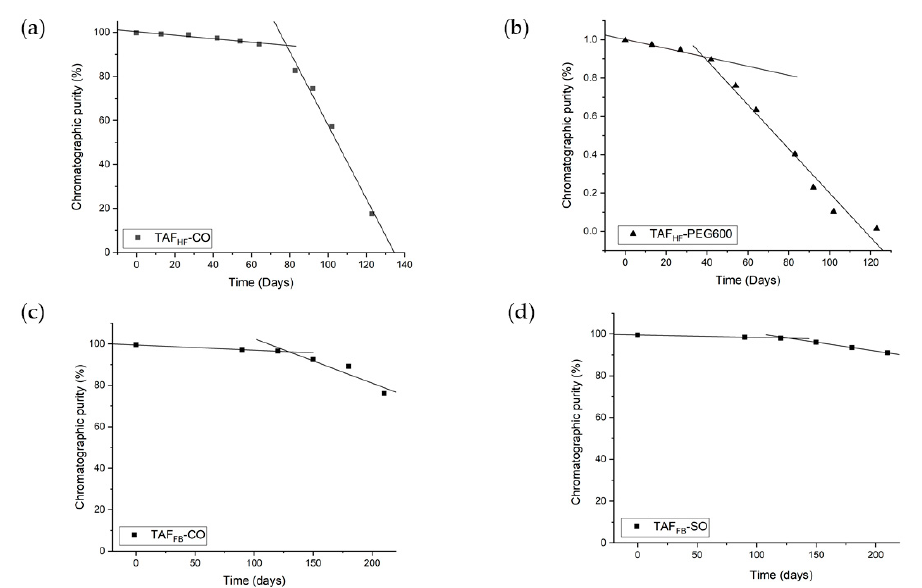
Figure 3. Degradation profiles of TAF HF ( a , b ) and TAF FB ( c , d ) formulations within implants with a wall thickness of 100 µm after exposure to simulated physiological conditions (37 °C, PBS). The fits (black lines) correspond to a two-line model for each formulation.